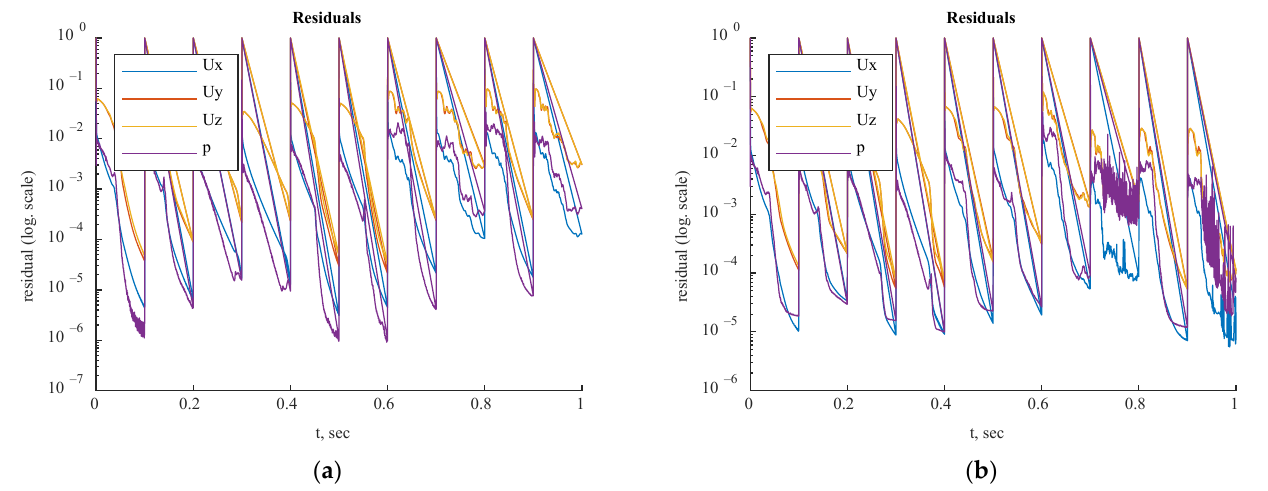
Figure 23. Residual history for steady-state simulation with shape of FDA nozzle model .